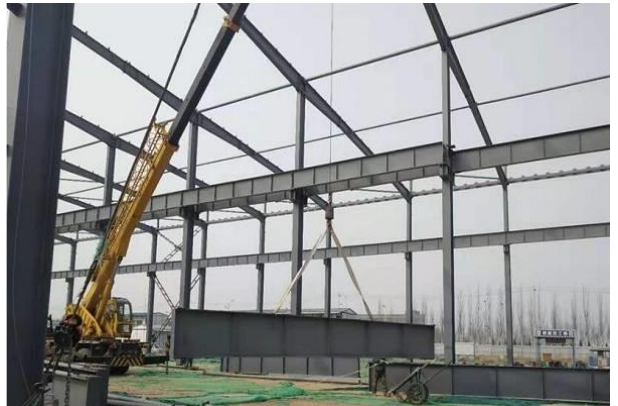
Figure 1. Photo of crane beam.